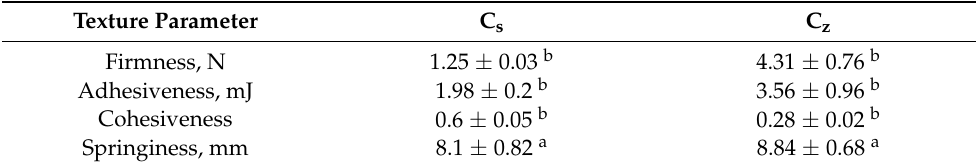
Table 3. Texture parameters values for marmalade samples.